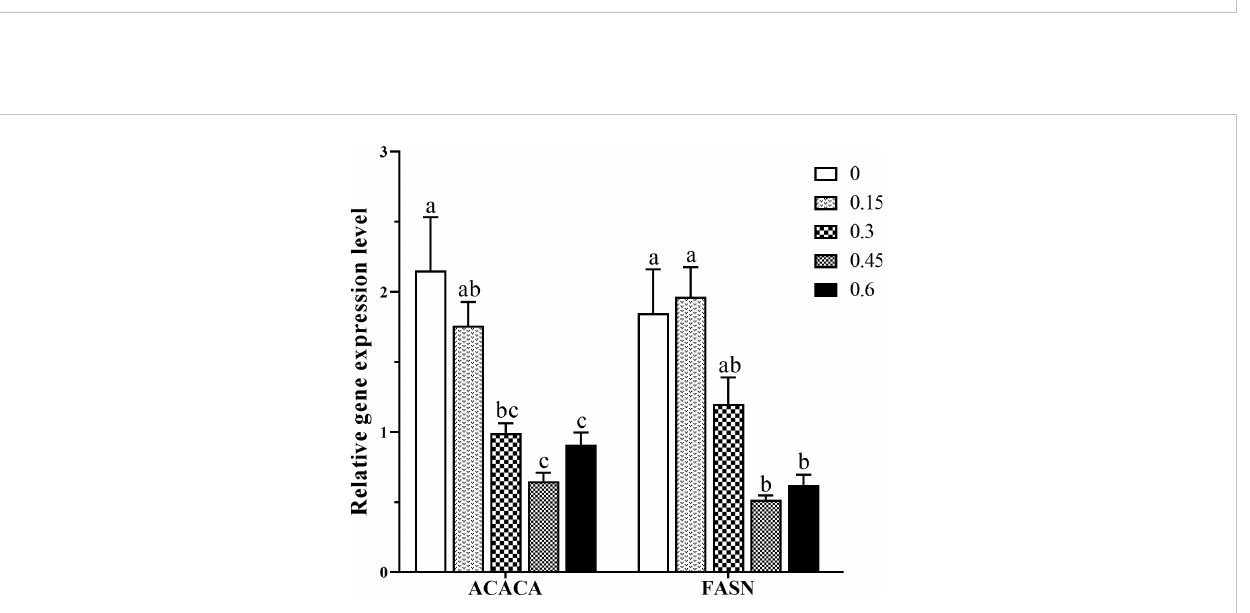
FIGURE 4 Effects of dietary bile acids levels on ACACA and FASN gene expression in the intestine of coral trout. Values are expressed as mean ± S.E.M (n=6). Different letters indicate signi fi cant differences among groups ( P < 0.05). ACACA, Acetyl-coenzyme A carboxylase- a ; FASN, fatty acid